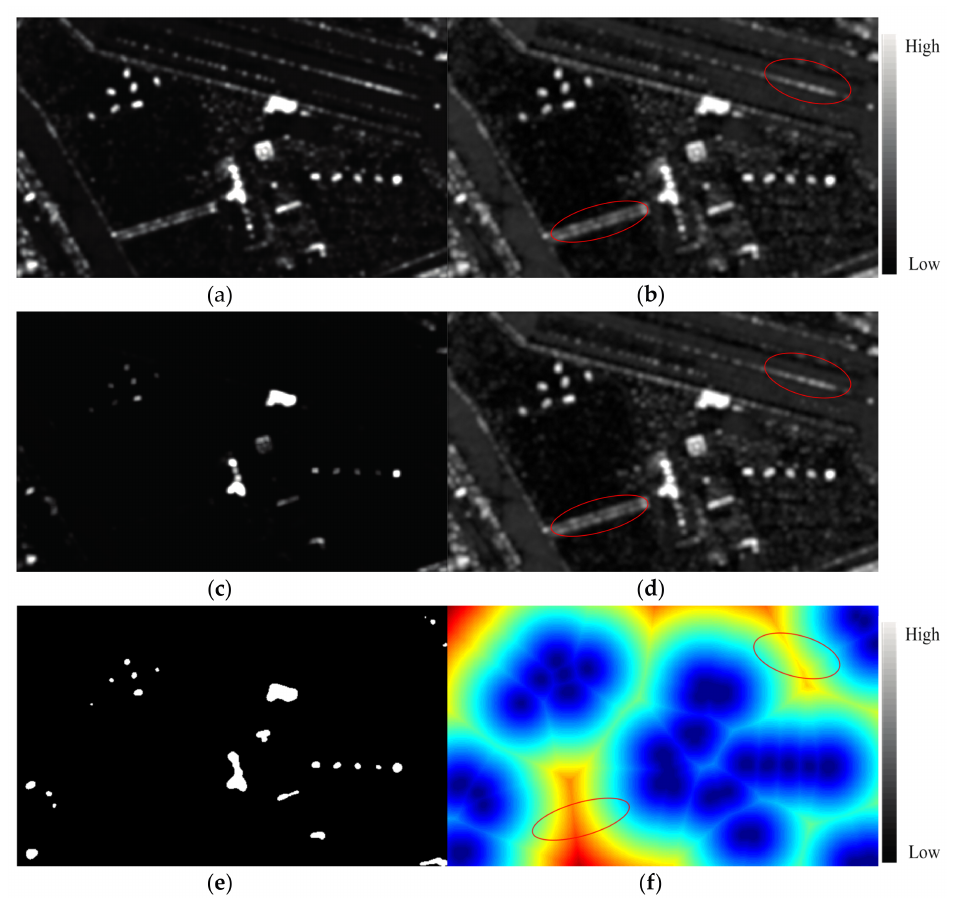
Figure 5. The intermediate results of our proposed saliency map generation algorithm. ( a ) Local saliency map with single scale; ( b ) Global saliency map with single scale; ( c ) Combined saliency map with single scale; ( d ) Multiscale saliency map before refinement; ( e ) Focus of attention points at single scale; ( f ) Distance image d foci ( x ) at single